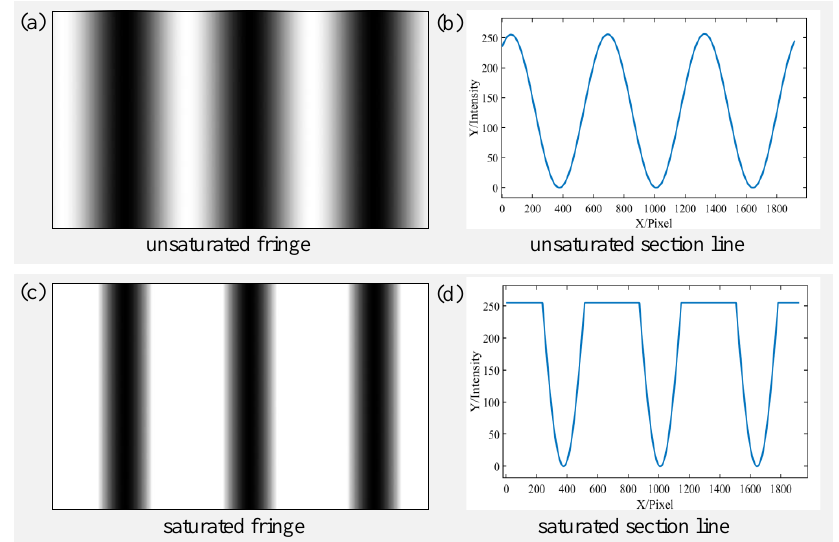
Figure 1. Examples of unsaturated and saturated fringes. Panels ( a , b ) are unsaturated fringe and its section line, respectively. Panels ( c , d ) are saturated fringe and its section line, respectively.